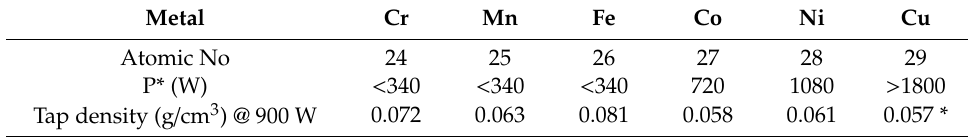
Table 1. Critical power (P*) for selected d-metal transition catalysts when M / Si = 1 / 3.